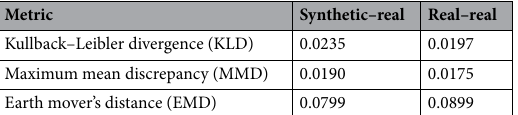
Table 1. Evaluation of synthetic microstructures generated by GAN.